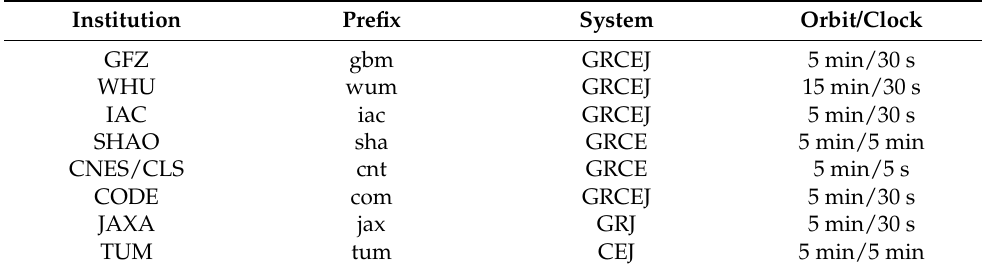
Table 1. Information of precise products and MGEX